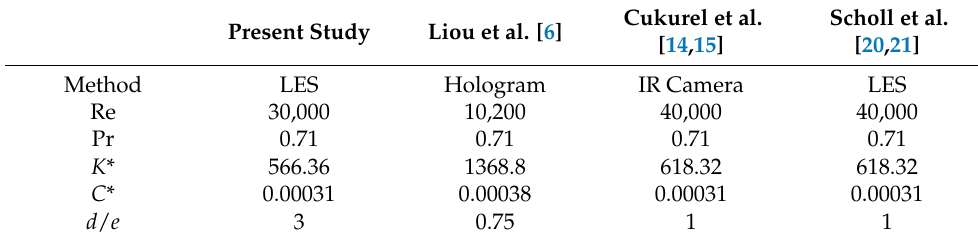
Table 1. Parameters related to conjugate heat transfer.